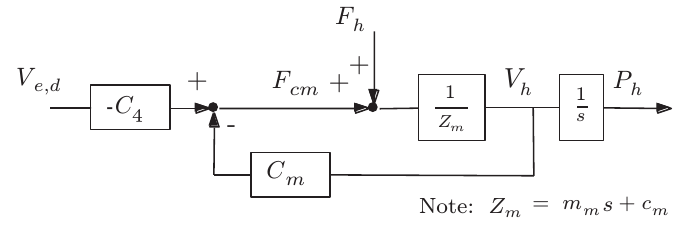
Figure 8. Control block diagram of the master.